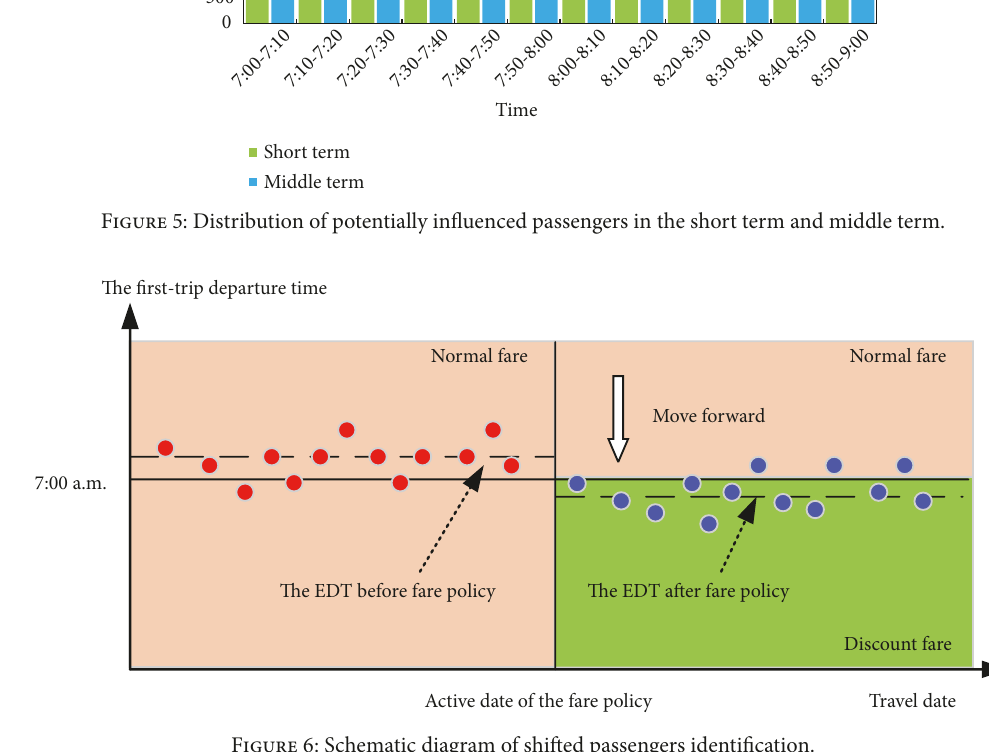
Figure 6: Schematic diagram of shifted passengers